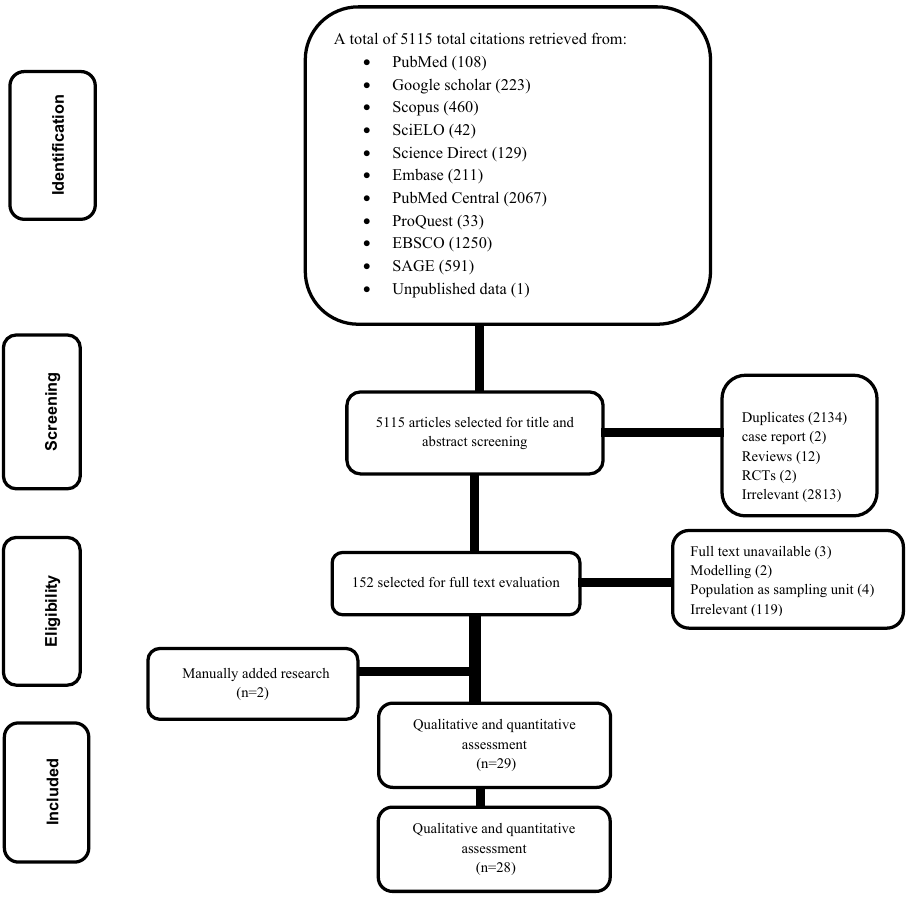
Figure 1. PRISMA flow-charts of studies included in meta-analysis of catastrophic costs among patients with